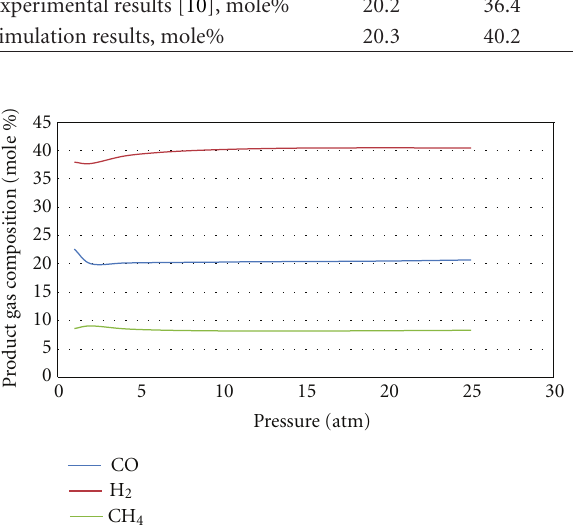
Figure 5: E ff ect of pressure on product gas composition.